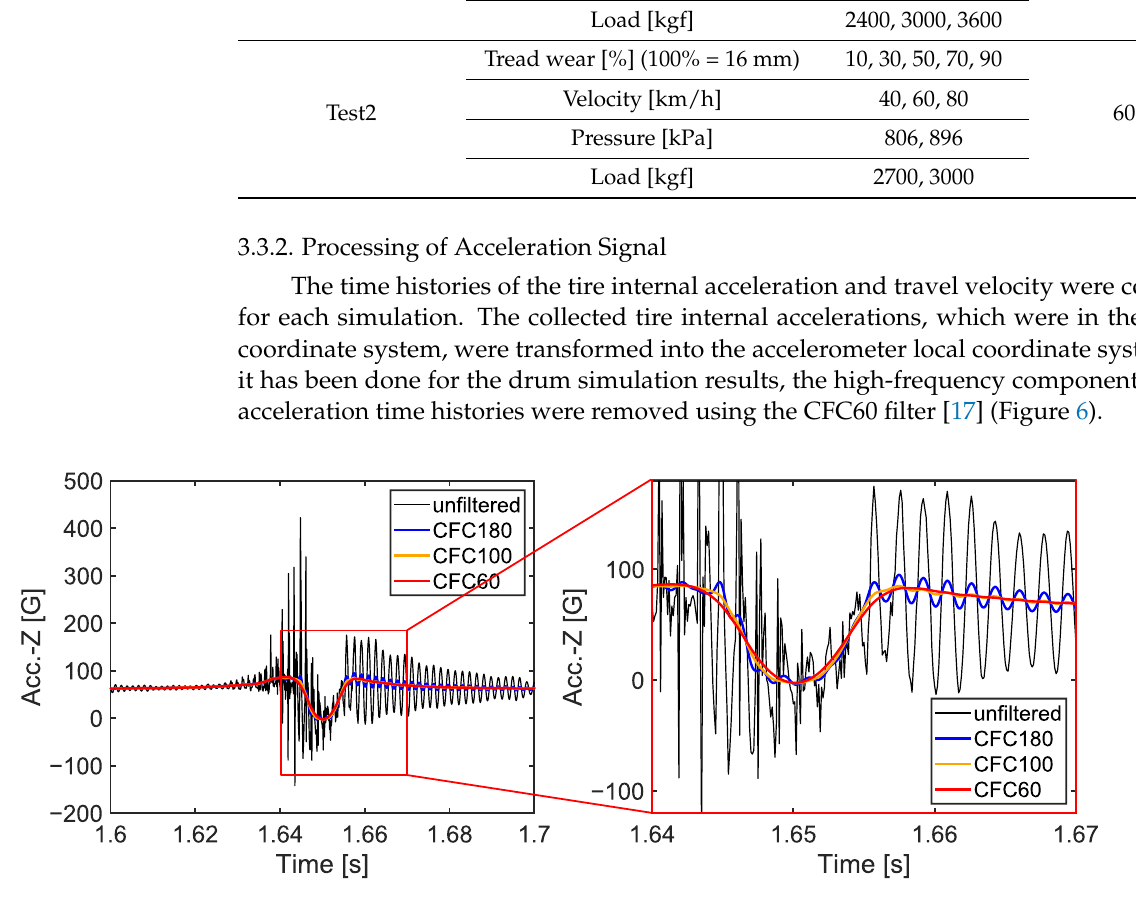
Figure 5. Set of tread depth conditions for rolling simulations.